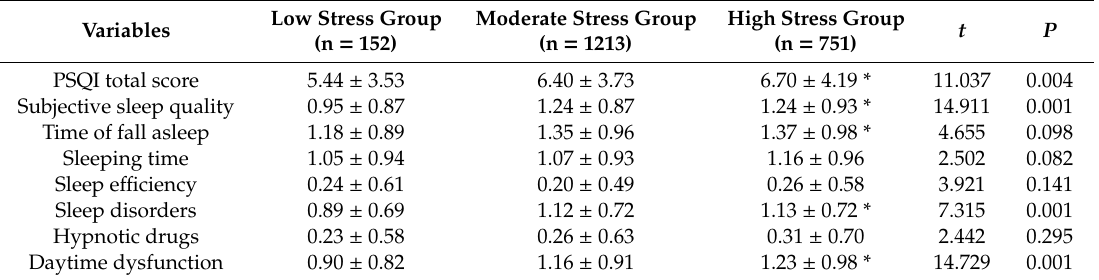
Table 3. Comparison of PSQI between di ff erent stress levels of workers in Xinjiang oilfield. ( X ± S